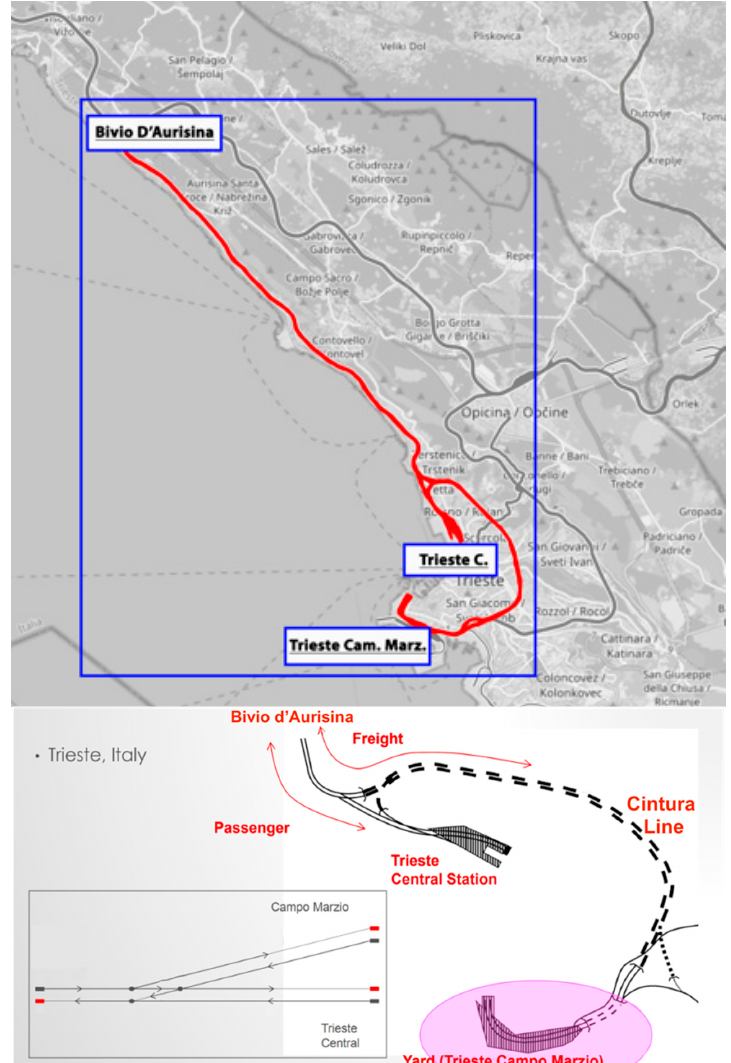
Figure 1. Trieste railway node.